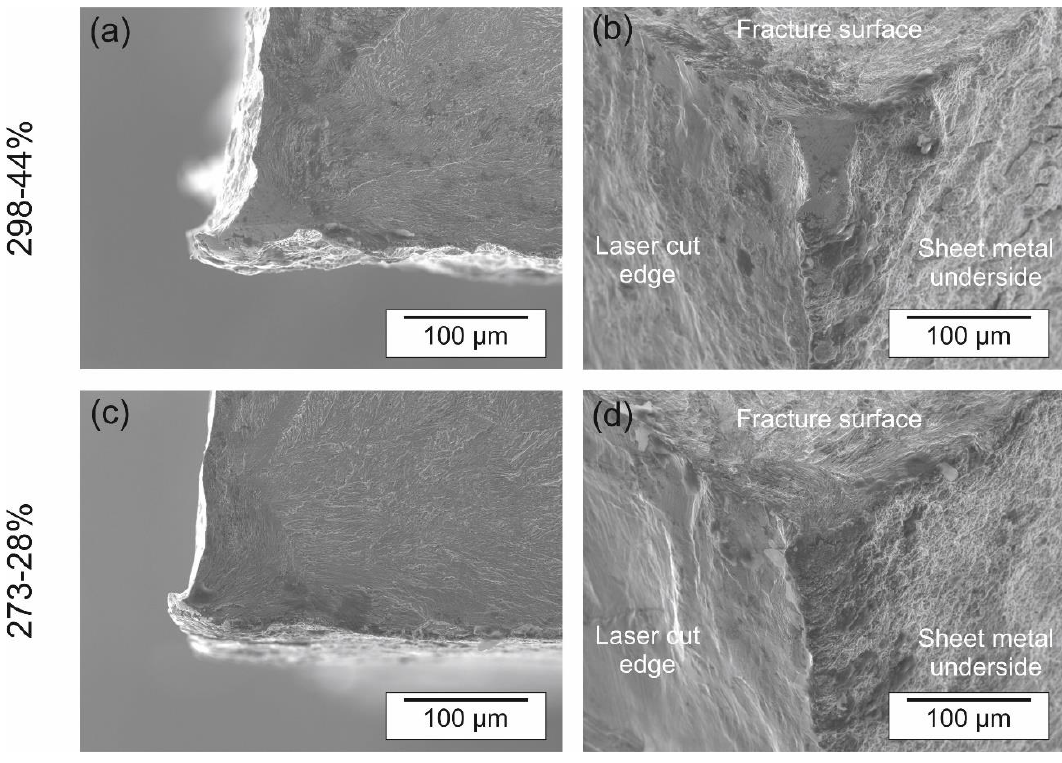
Figure 9. Selection of fracture surfaces captured by SEM. ( a ) 298K-44%, top view, ( b ) 298K-44%, 45°-perspective view, ( c ) 273K-28%, top view, ( d ) 273K-28%, 45°-perspective view.